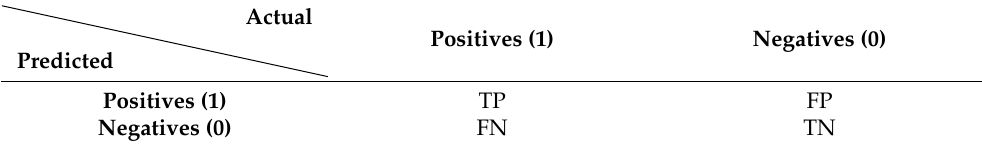
Table 2. Confusion matrix for evaluation classification